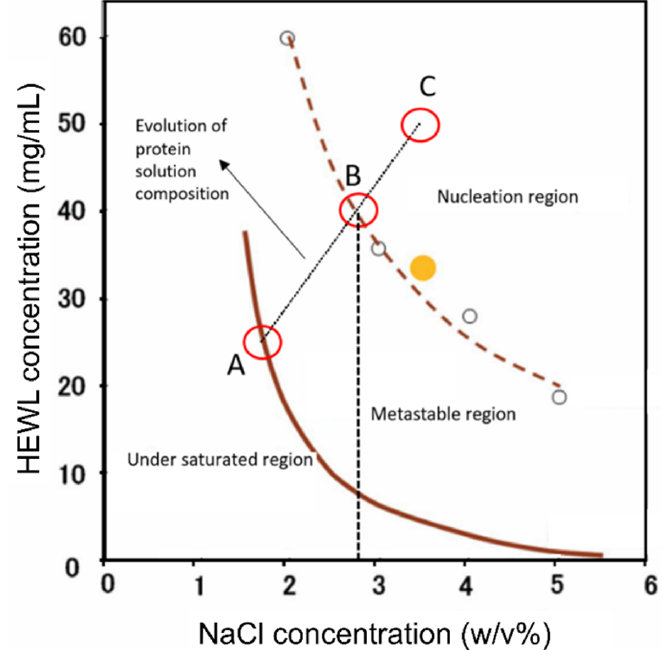
Figure 6. Solubility diagram of lysozyme extracted adapted from [43]. ( A ) corresponds to the composition of the crystallizing solution in the beginning of the experiment (HEWL 25 mg/mL and NaCl 1.75% ( w / v )); ( B ) corresponds to the composition of the crystallizing solution when crossing the boundary for nucleation to occur (HEWL 41 mg/mL, NaCl 2.9% ( w / v )); ( C ) corresponds to the equilibrium point with the stripping solution (HEWL 50 mg/mL, NaCl 3.5% ( w / v )). The brown solid curve corresponds to the saturation boundary line, the brown dashed curve corresponds to the nucleation boundary line, and the dashed black vertical line shows the NaCl concentration in the crystallizing solution in the moment nucleation begins.